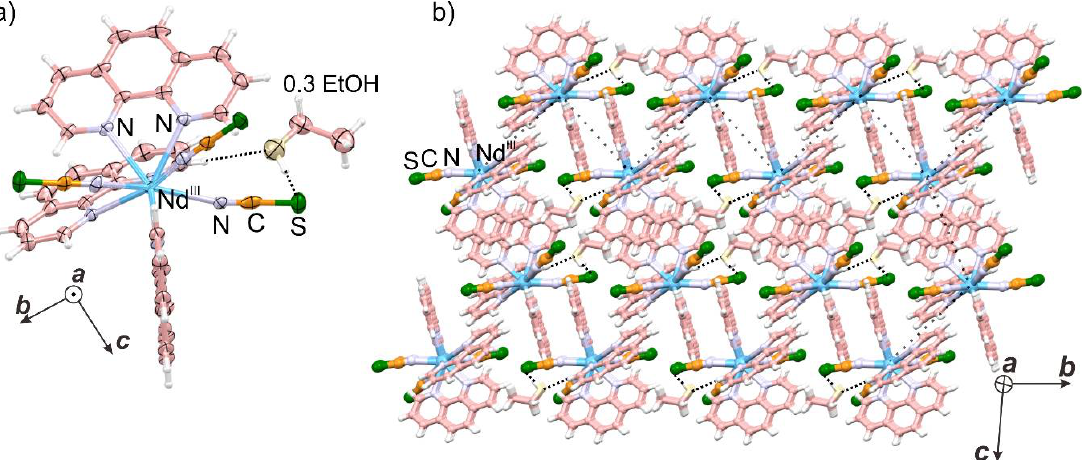
Figure 1. The crystal structure of 1 - S : ( a ) the anisotropic unit with atomic labeling; ( b ) the representative crystal packing along the bc -crystallographic plane. The complex 1 - Se has similar crystal packing. The densely dotted lines correspond to hydrogen bonding, and sparsely dotted zig-zag connections indicate the packing arrangement of Nd (III) ions.